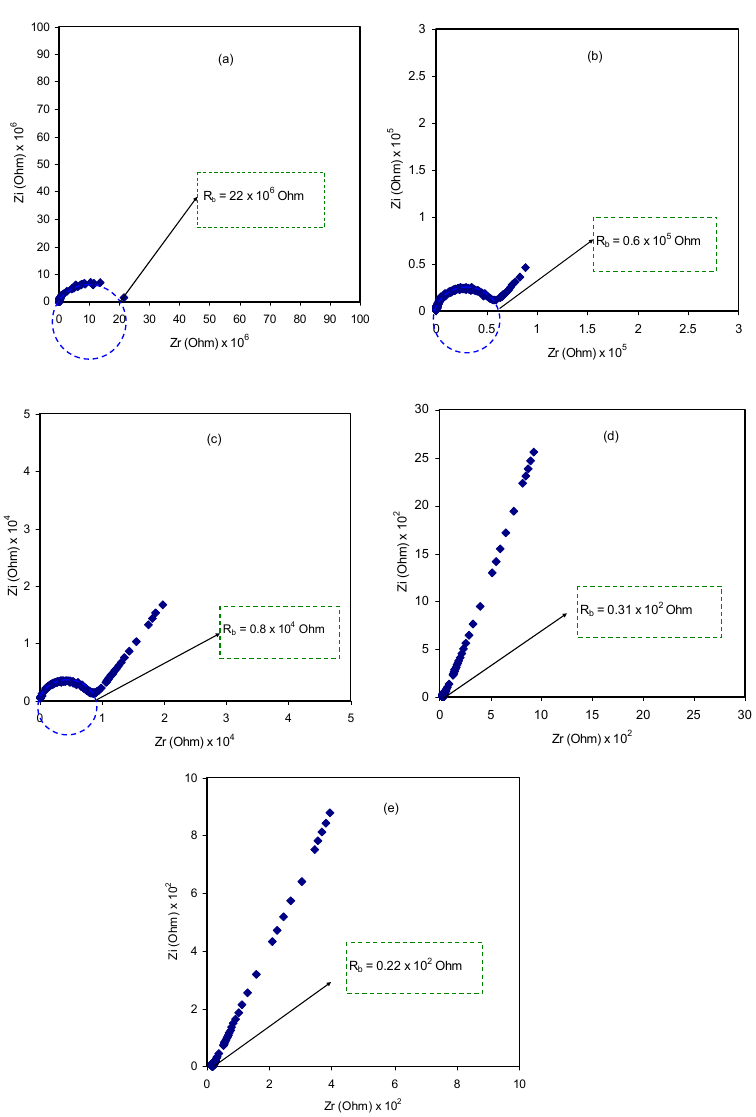
Figure 2. Impedance plots at ambient temperature for ( a ) Pure CS:PEO (CSPX0);( b ) CSPX1, ( c ) CSPX2, ( d ) CSPX3, and( e ) CSPX4 samples.